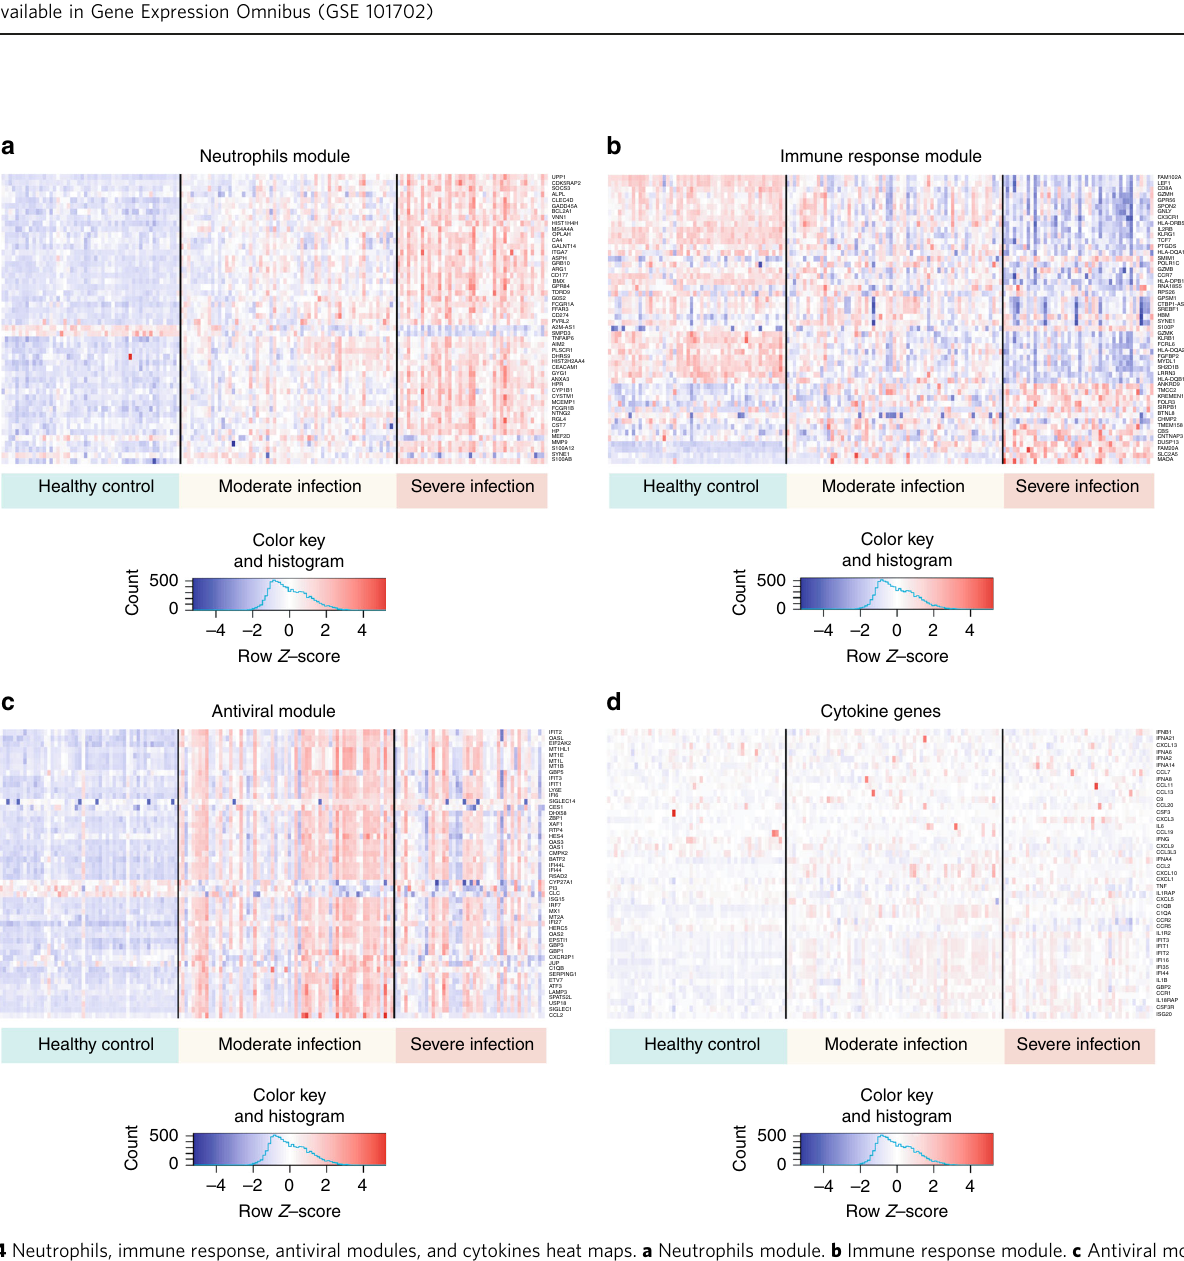
Fig. 3 Main modules of host response to in fl uenza infection. a Overview of main study fi ndings. Weighted gene co-expression network analysis identi fi ed 20 modules. Horizontal bars represent statistical signi fi cance of eigengene values in each module, with disease severity as a factor in the ANOVA model. Dendrogram (left and also magni fi ed below) shows gene numbers in each module. Six modules were kept because they were statistically signi fi cant in ANOVA model ( p < 0.01) and met minimal gene number criteria (>300) for further analysis. Biological themes of these six modules are shown (right); one module did not show clear biological theme (hence named “ Indeterminate ” ). b Gene-expression space in the dendrogram (based on an enlarged version of the dendrogram in above left). The statistically signi fi cant modules ( n = 6) are highlighted in color; their number of genes are indicated by numbers inside the circles (circle sizes are proportional to statistical signi fi cance). The nonstatistically signi fi cant modules ( n = 14) are shown as branches without circles; their number of genes are given at the foot of each branch. Gene-expression distance is indicated by (1) location in the dendrogram tree (modules within the same branch are more similar than those from different branches) and (2) dissimilarity scale (left-hand side of the dendrogram), which indicates the degree of gene connectivity between modules. c (Left) Eigengene differentials of moderate infection: eigengene differentials in each module represent the differences of eigengene mean expression levels between moderate infection and healthy controls (graphed with an offset of 0.2). (Right) Eigengene differentials of severe infection: eigengene differentials in each module represent the differences of eigengene mean expression levels between severe and moderate infection (graphed with an offset of 0.2). Stars above columns indicate statistically signi fi cant differences (by pairwise t test) between the groups. The actual levels of eigengene differentials between severe and moderate infection are also shown in an inserted table on the right. The source data